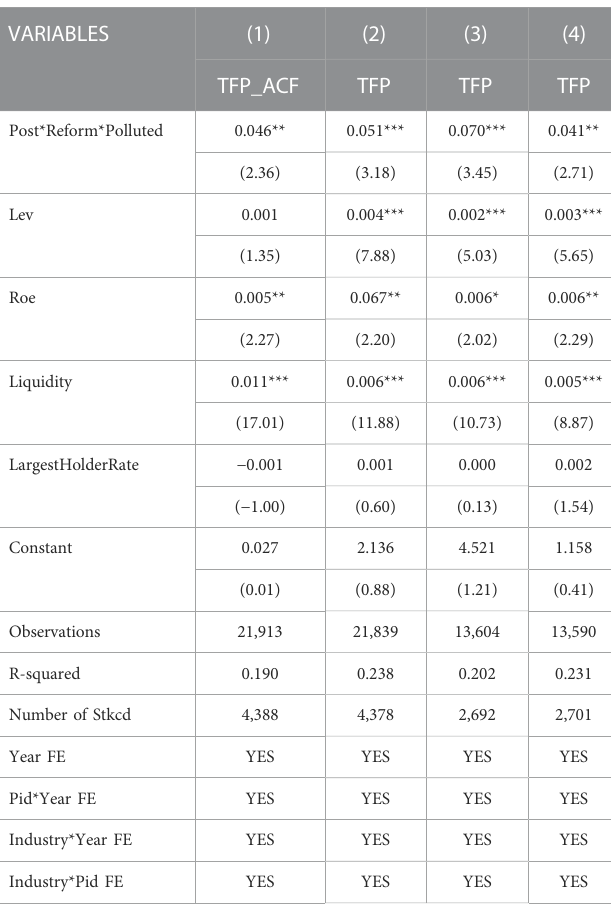
TABLE 3 Robustness